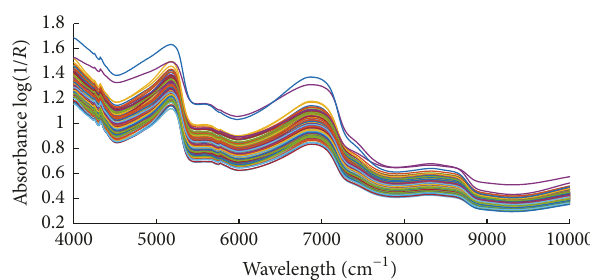
Figure 4: Typical absorbance spectra of all apple samples between 4000 and 10,000 cm −1 .